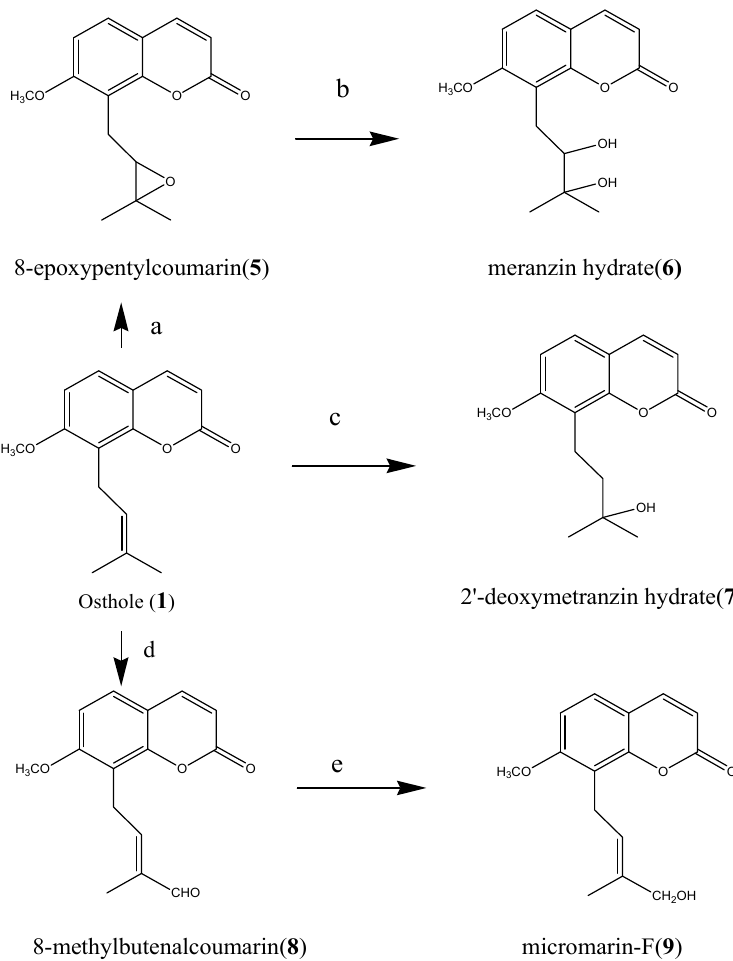
Figure 3. The scheme of the synthetic procedure and the chemical structures of Compounds 5 - 9 . Reagents: ( a ) m -CPBA, CH ( c ) Hg(AcO) , NaOH, THF-H 2 borohydride,